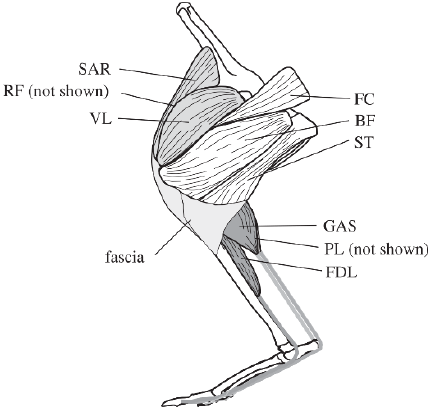
Figure 1. Schematic drawing of the left hind limb of a kangaroo